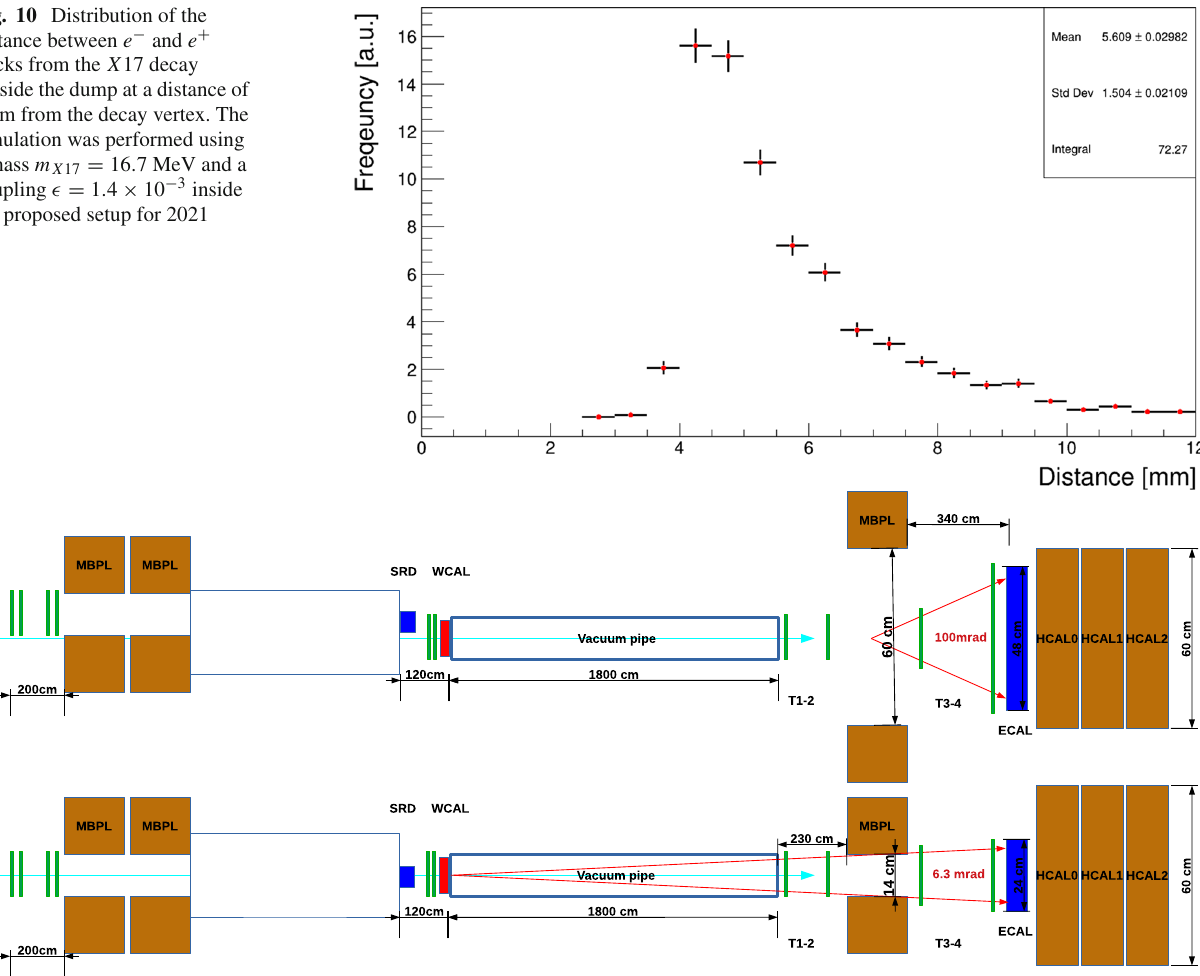
Fig. 10 Distribution of the distance between e − and e + tracks from the X 17 decay outside the dump at a distance of 18 m from the decay vertex. The simulation was performed using a mass m X 17 = 16 . 7 MeV and a coupling (cid:2) = 1 . 4 × 10 − 3 inside